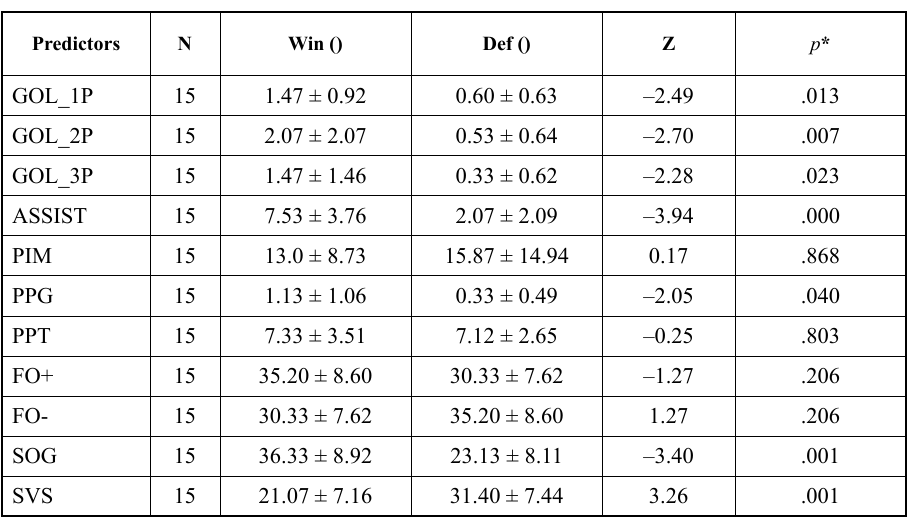
ween winning and defeated teams (Mann-Whitney